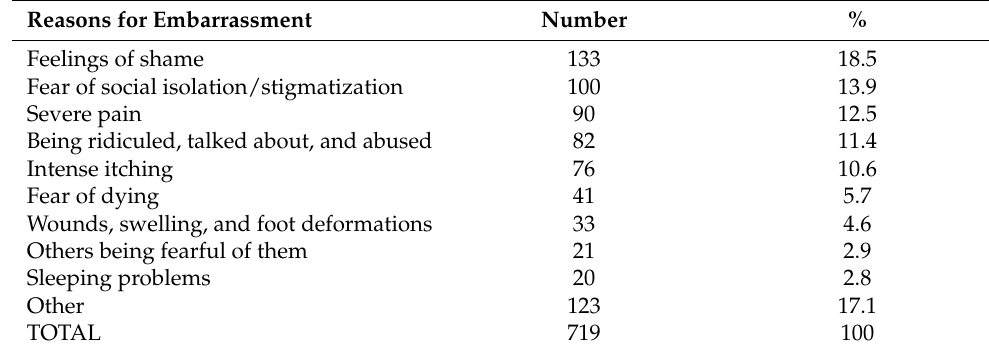
Table 3. Reasons for feeling embarrassed of tungiasis (open-text question).